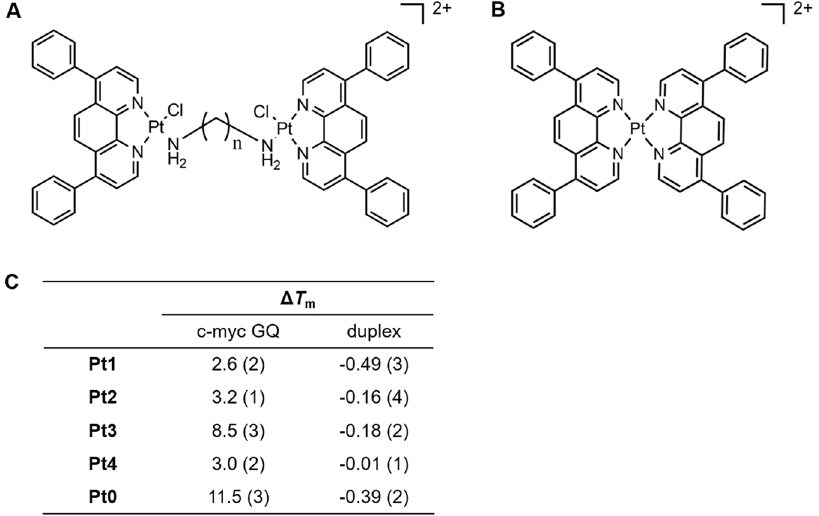
Figure 1. ( A ) Structures of dinuclear platinum complexes Pt1-Pt4 , n = 7–10. ( B ) Structure of Pt0 . ( C ) Enhancements of melting temperatures ( Δ T m ) of c-myc GQ and duplex DNA in the presences of dinuclear Pt complexes and Pt0 . Error bars on last significant digit are listed in